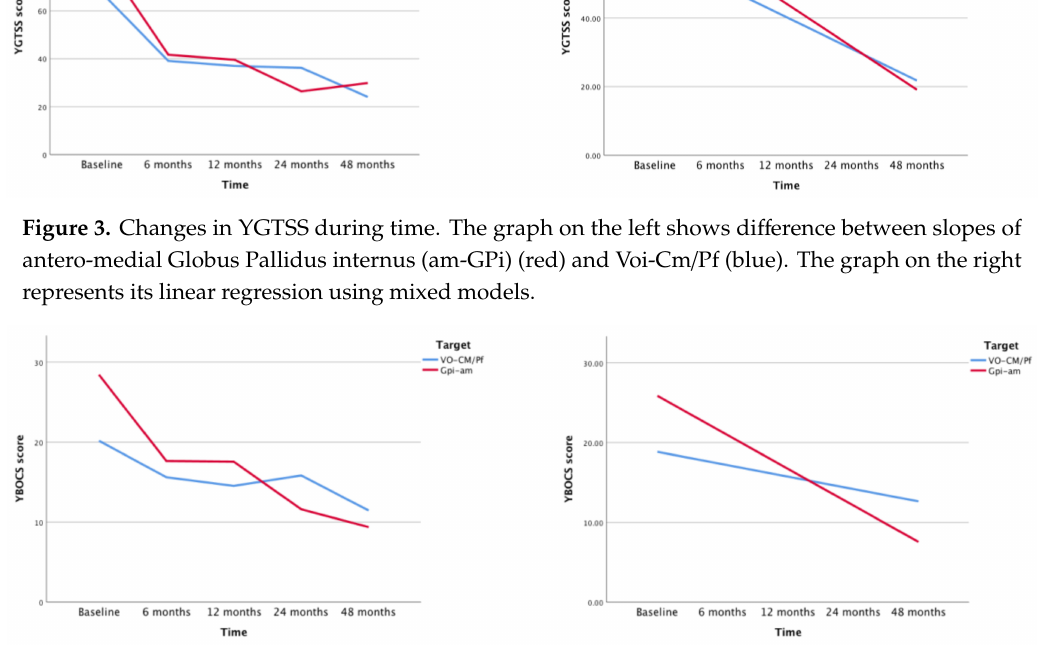
Figure 4. Changes in YBOCS during time. The graph on the left shows di ff erence between slopes of am-GPi (red) and Voi-Cm / Pf (blue). The graph on the right represents its linear regression using mixed